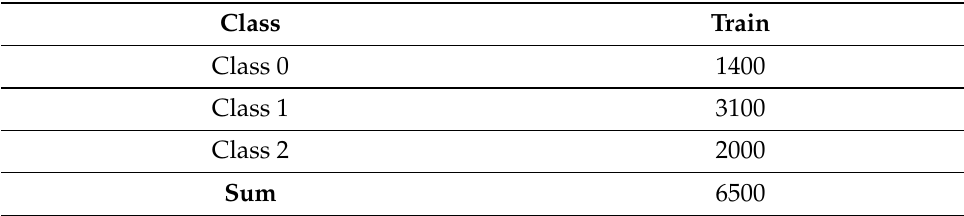
Table 9. Number of classes in the training dataset generated by the GANs.